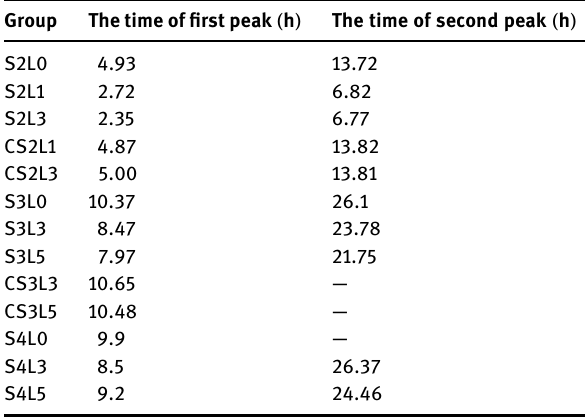
Table 3: The time of the hydration exothermic